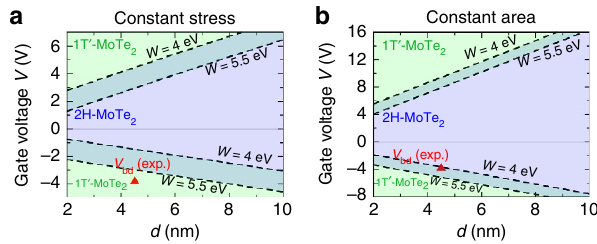
Figure 5 | Phase control of MoTe 2 through gating at constant stress and constant area. ( a , b ) Plotted are phase stabilities of monolayer MoTe 2 with respect to gate voltage V and dielectric thickness d using the capacitor structure shown in Fig. 4a. In each phase diagram, there exist two phase boundaries that vary with the work function W of the capacitor plate. Between the two phase boundaries, semiconducting 2H is more stable, and outside 1T 0 is the stable structure. The required transition gate voltage is smaller in the constant-stress case ( a ) than in the constant-area case ( b ). For a constant-stress scenario, a negative gate voltage as small as (cid:2) 1 to (cid:2) 2V can trigger the semiconducting-to-semimetallic phase transition in monolayer MoTe 2 . The red triangle represents the breakdown voltage of a 4.5-nm-thick HfO 2 film obtained experimentally 35 . (3.9 dielectric constant) with gate voltages as large as (cid:2) 50 V. For monolayer MoTe 2 (rather than few layers), our model predicts that a gate voltage 4 200 V is required to drive the phase transition for this device configuration. Both the increase of dielectric thickness (from 5 to 270 nm) and the decrease of dielectric constant (from 25 for HfO 2 to 3.9 for SiO 2 (ref. 35)) will result in larger transition gate voltages than shown in Fig. 5. To observe the 2H-1T 0 phase transition in a device, choosing a dielectric medium of large dielectric constant and dielectric performance will be critical.